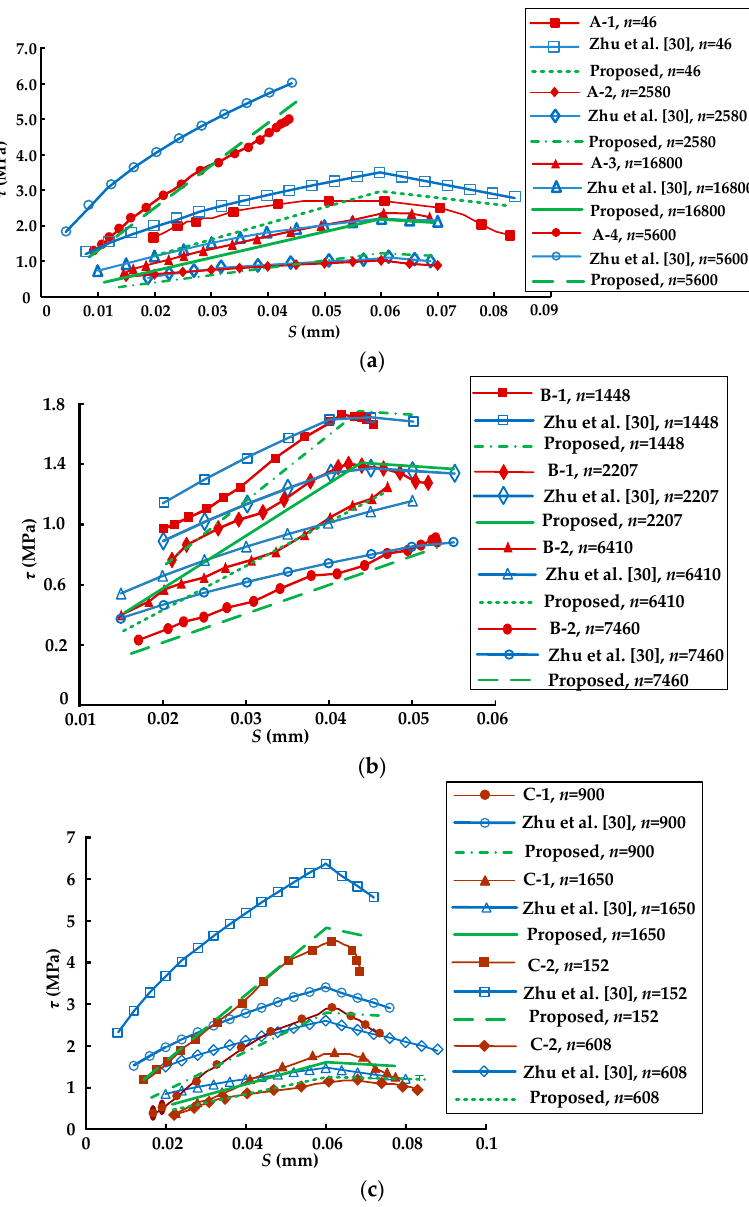
Figure 7. The comparison of the existing model [30], the proposed model, and the test results of the specimens in groups: ( a ) A; ( b ) B; and ( c ) C.